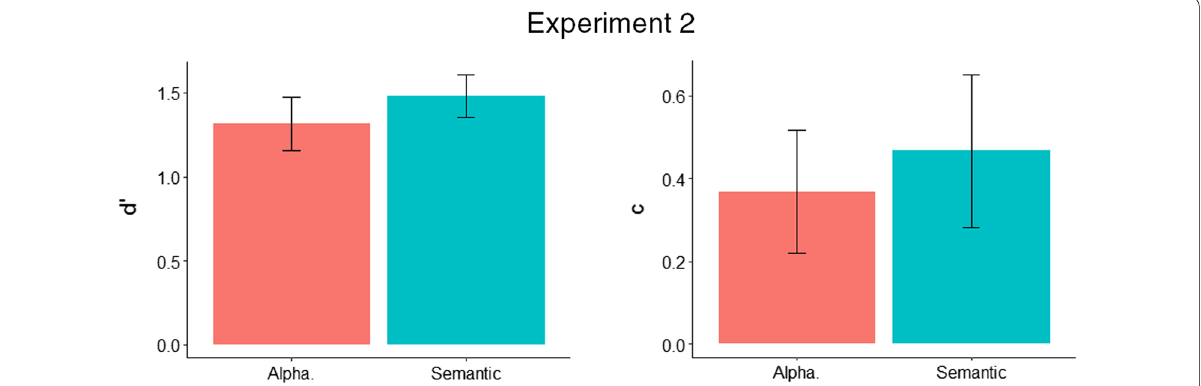
Fig. 6 d ′ and c for the semantic and alphabetic training groups in Experiment 2 (error bars show 95% CIs)